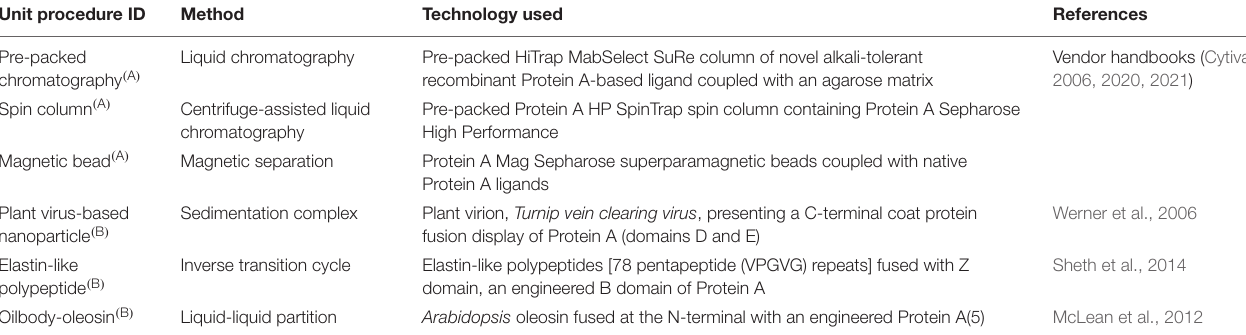
FIGURE 1 | Monoclonal antibody production consists generically of product accumulation, clarification, initial purification, formulation, and fill & finish. Here we investigate six technologies for the capture step within the first purification step in a space mission context using extended equivalent system mass. The manufacturing origin of the capture reagent is denoted as either (A) abiotic or (B) biotic. TABLE 1 | List of Protein A-based monoclonal antibody capture step unit procedures included for